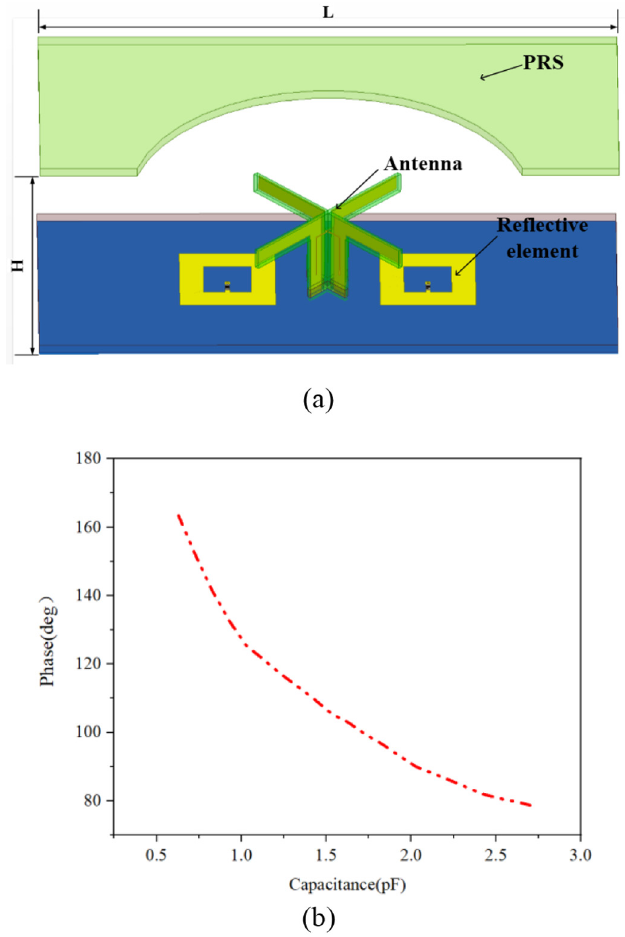
Fig. 4. (a) Perspective view of FP resonance cavity, (b) simulated result of phase